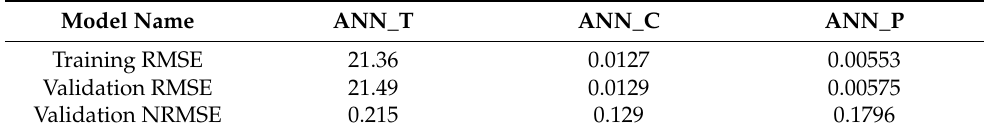
Table 8. Model evaluations of the ANN models for endpoint temperature, carbon, and phosphorus.